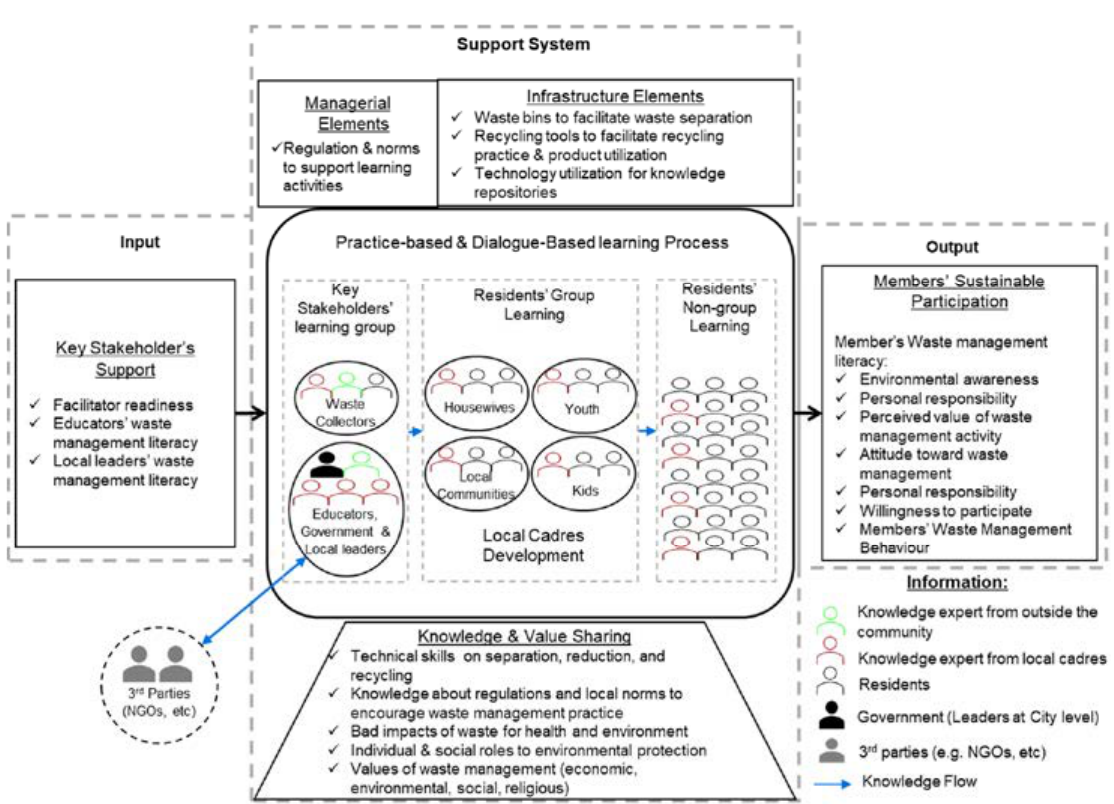
Fig. 9: The proposed design of resident‐based learning model for waste management participation